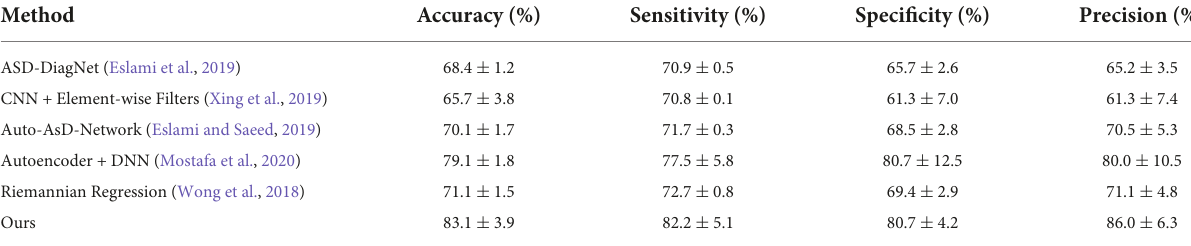
TABLE 5 Comparison with the state-of-the-art methods using other brain